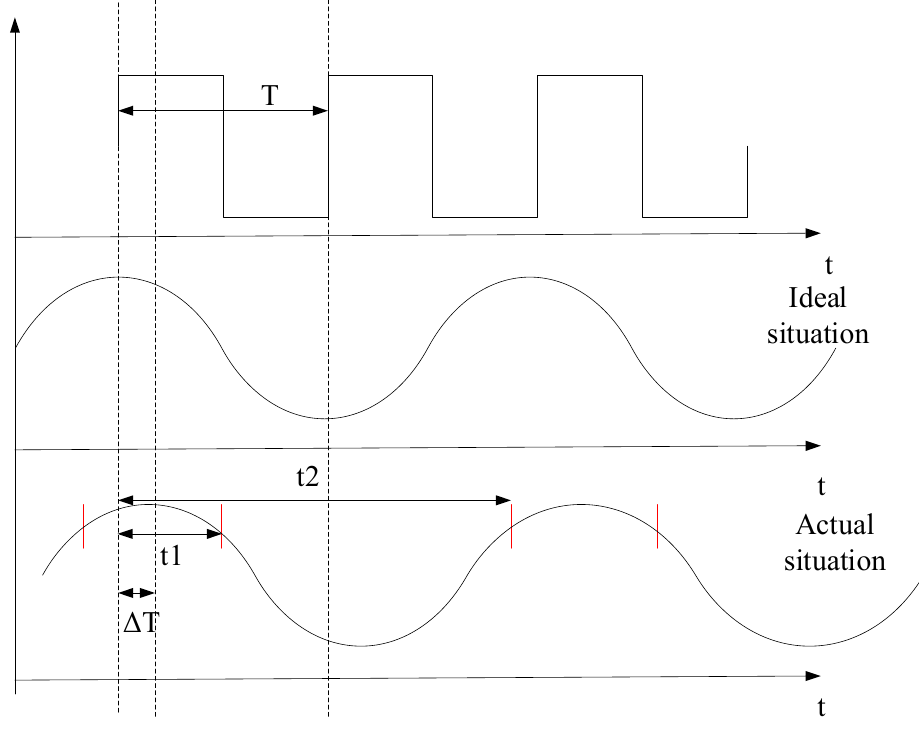
Figure 4. The phase diagram of the micromirror.